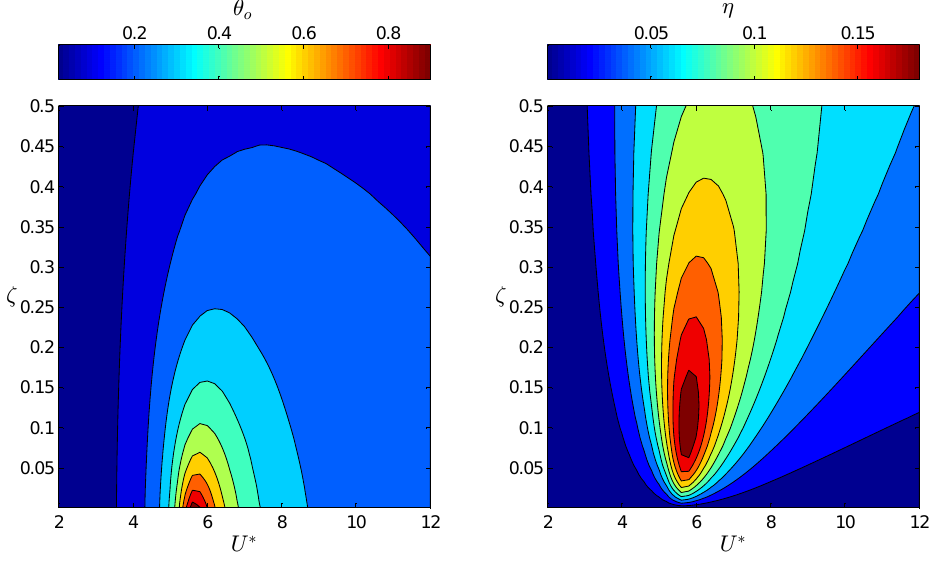
Figure 10. Contours of θ o and η as functions of U ∗ and ζ for L ∗ = 0.8 and m ∗ = 75.